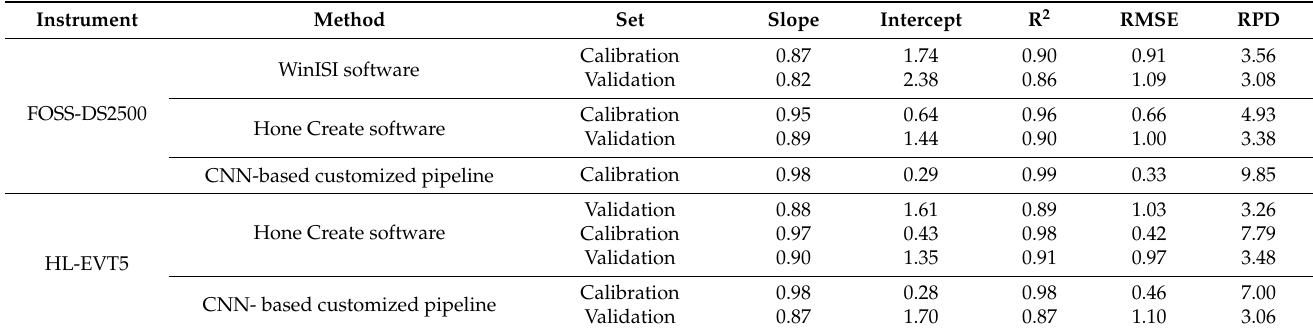
Figure 5. Means of the near-infrared (NIR) spectra of the grain samples of five cereal species produced using ( A ) FOSS-DS2500, 400–2498 nm; solid line (–), and ( B ) HL-EVT5, 1350–2550 nm; dashed line (—) instruments. Different crops are distinguished by color (Legend: finger millet = brown; foxtail millet = orange; maize = yellow; pearl millet = grey; sorghum = green). Table 2. Comparative metrics of NIR spectroscopy calibration (80%) and validation (20%) mod- els developed using combinations of two different instruments (FOSS-DS2500 and HL-EVT5) and three model-building methods (WinISI software, Hone Create software, CNN-based customized pipeline) for protein content estimation in grains of multiple cereal species. Legend: R 2 = coefficient of determination; RMSE = Root Mean Squared Errors, RPD = ratio of prediction to deviation, CNN = convolutional neural